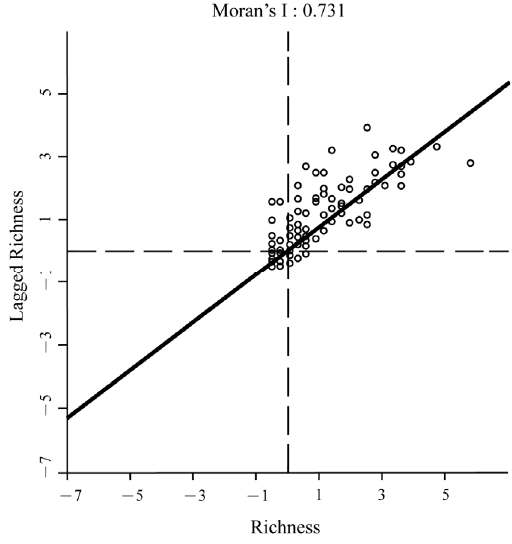
Figure 2. The Moran’s I of subgenus Cerasus . The closer the Moran’s I is to 1, the more pronounced the aggregation effect is in the spatial distribution.